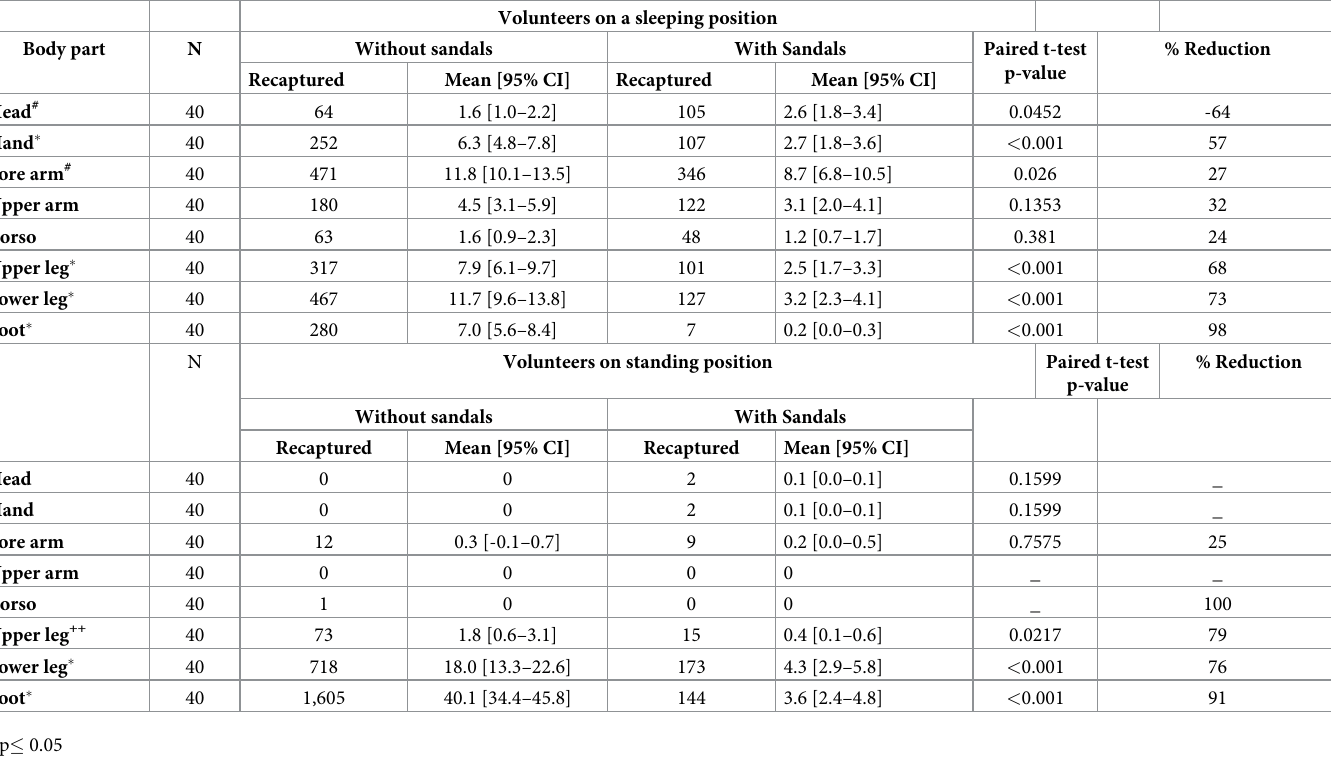
Table 4. Mean number of Anopheles arabiensis caught at different body parts of volunteers with and without the transfluthrin-treated sandals. Volunteers on a sleeping position Without sandals With Sandals Paired t-test